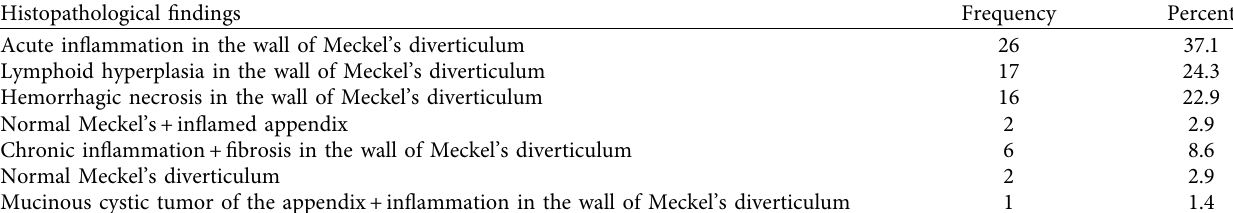
Table 4: Showing the histopathological findings of the excised samples.